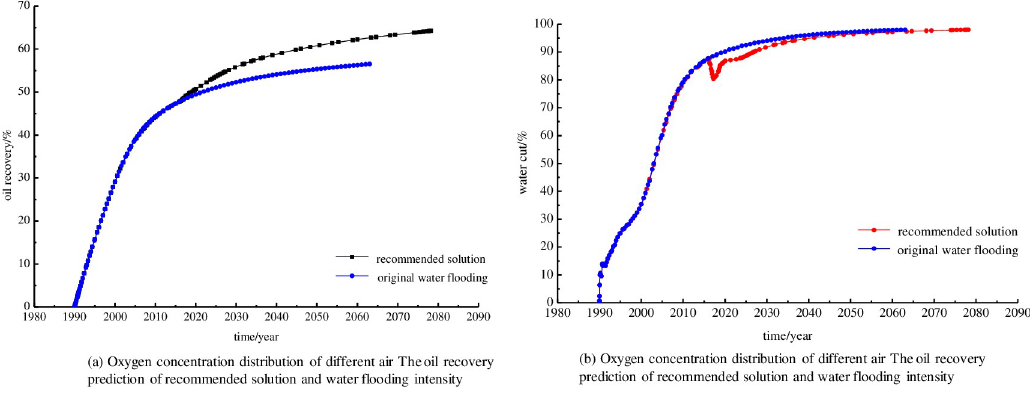
Fig 13. The oil recovery and water cut prediction of recommended solution and water